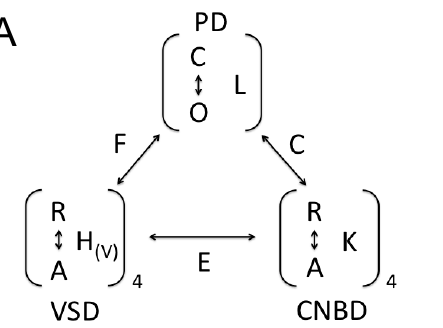
Figure 3. Inhibitory effects of propofol on HCN2 channels. ( A ) Superimposed current traces from HCN2-expressing CHO cells, recorded using the above-mentioned pulse protocol, before (upper, control) and 2–3 min after exposure to propofol at 10 µ M (lower). The horizontal line to the left of the current traces indicates zero level. ( B ) Current recordings in a cell preloaded with cAMP (50 µ M) via pipette. The concentration of propofol is the same as A. ( C ) The percentage inhibition of the saturating current density at various concentrations of propofol in the presence and absence of cAMP. Data represent the mean ± S.E.M. *, p < 0.05. ( D ) Shifts in V h caused by propofol at various concentrations in the presence and absence of cAMP. Bars represent the mean ± S.E.M. ( n = 6). The different letters in ( C , D ) indicate a significant difference at p < 0.05 according to the Tukey’s multiple range test and t -test (* indicates the difference in the presence and absence of cAMP; a, b, c, indicate different propofol concentration.).